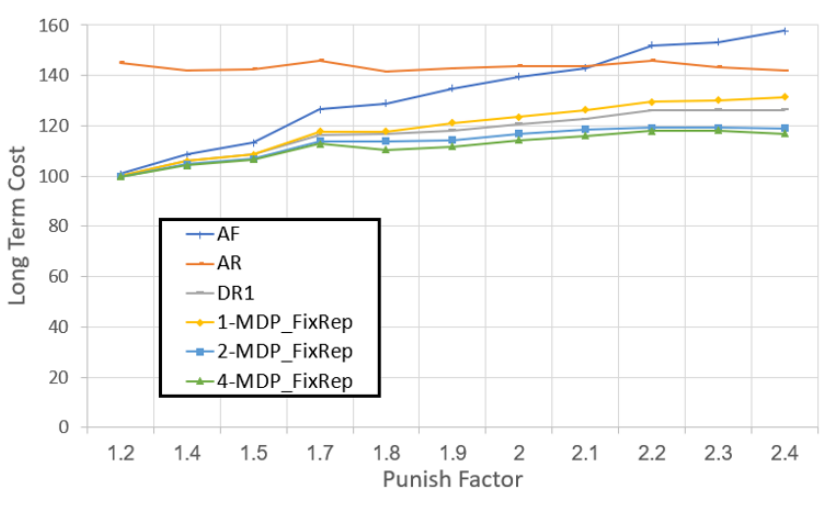
Figure 7. Long-term costs as a function of the punish factor. Evaluating the N-MDP FixRep algorithm.